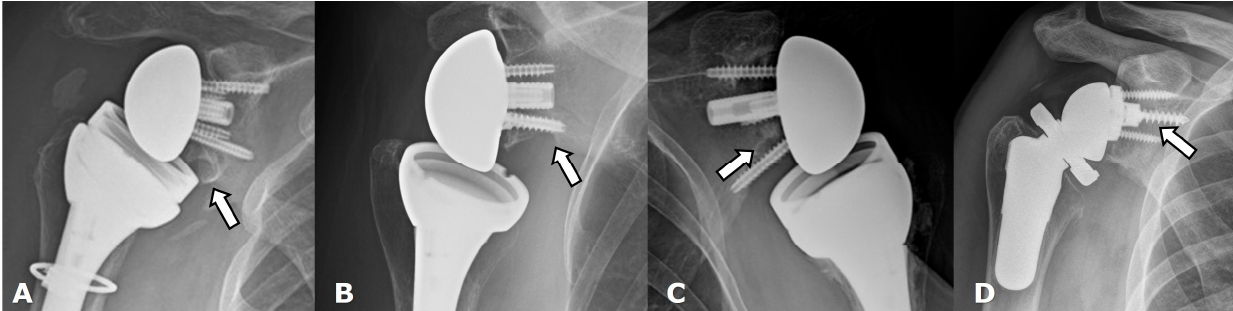
Figure 29. Frontal radiographs. Scapular notching grading by using Sirveaux Classification in four different patients with a reverse total shoulder arthroplasty. ( A ). Grade 1. ( B ). Grade 2. ( C ). Grade 3. ( D ). Grade 4.